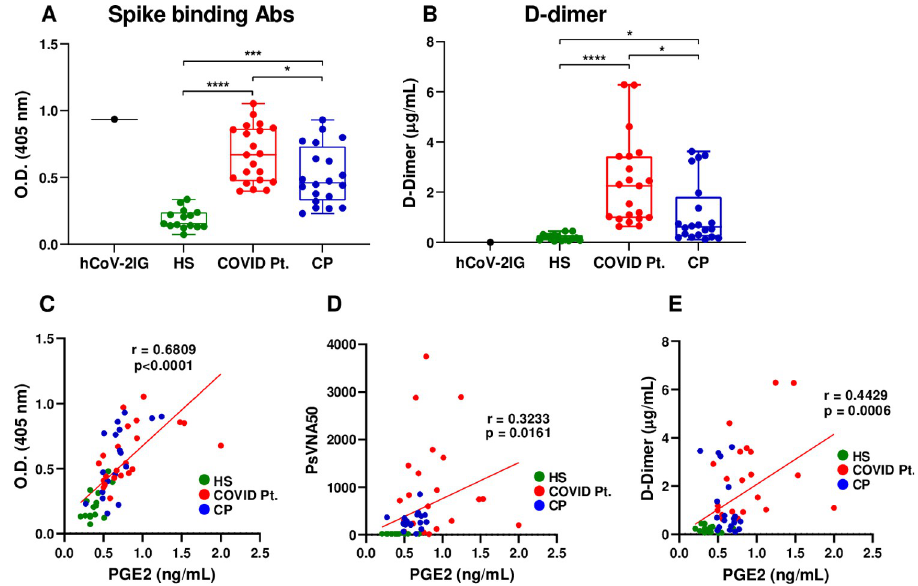
Fig 6. Strong correlation between PGE2 produced in monocyte cell culture and levels of anti-CoV-2 spike binding antibodies in human plasma. Quantities of SARS CoV-2 spike binding antibodies (A) and of DD (B) in samples of hCoV-2IG (N = 1), HS (N = 15), COVID Pt. (N = 21), and CP (N = 20) were measured by ELISA. Data is shown as mean antibody concentrations (O.D. at 405 nm) ± SD (A) and as mean DD concentrations ± SD (B). � P < 0.05, ��� P < 0.005, ���� P < 0.0001, by one-way ANOVA test followed by Dunn’s multiple comparison test. Correlation between the quantity of CoV-2 spike binding antibody (C) or of antibody neutralizing titers (PVsVNA50) (D) in plasma samples and quantity of PGE2 in monocyte cell culture supernatants or between PGE2 in monocyte cell culture supernatants and quantities of DD in human plasma (E). Pearson’s correlation coefficient (r) was calculated for plasma samples from healthy subjects, COVID-19 patients, and convalescent plasma; hCoV-2IG (a highly concentrated purified commercial IgG product) was not included in the analysis (C, D, and E).